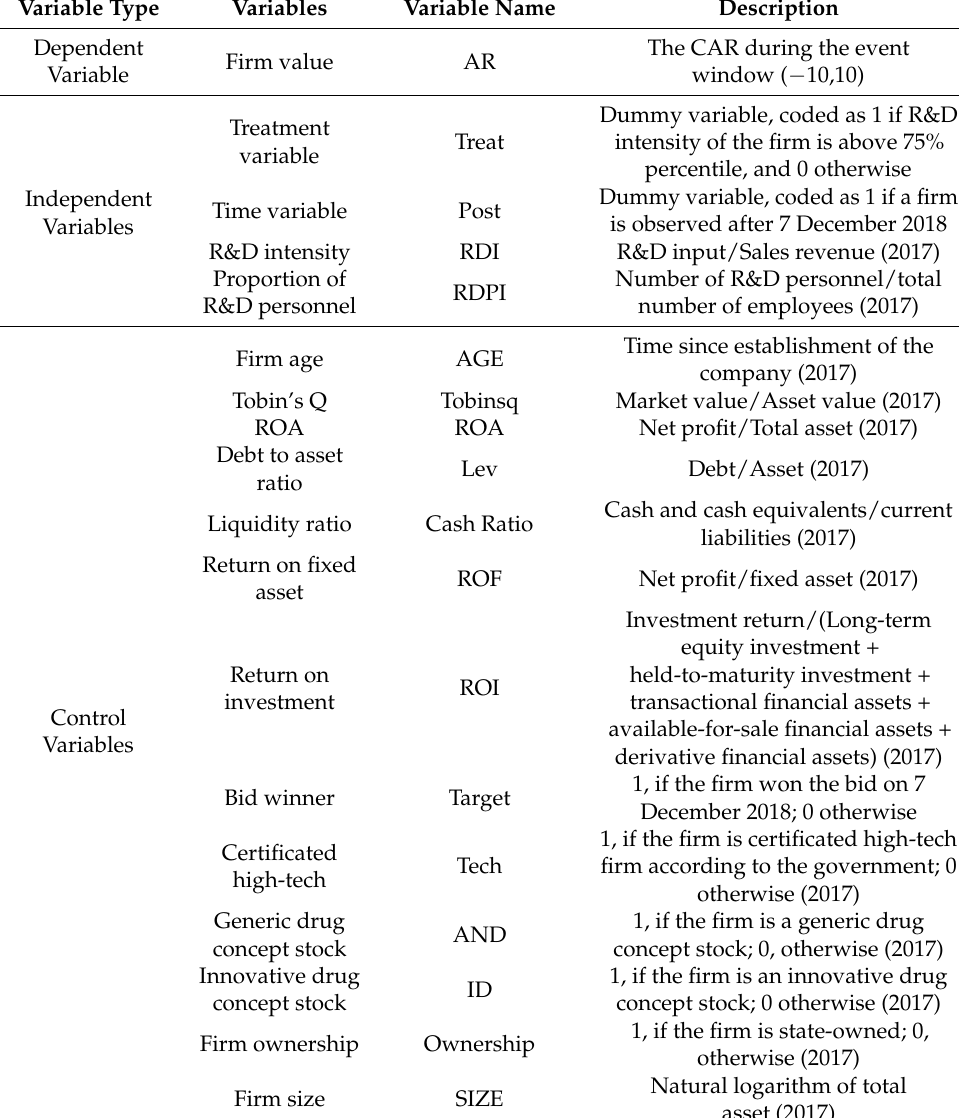
Table 2. Variable description and